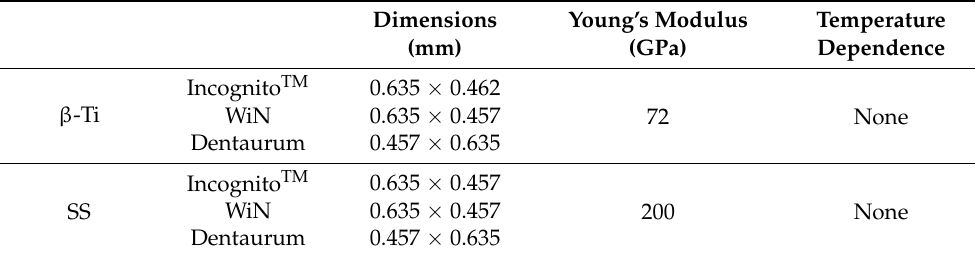
Table 1. Physical, mechanical and thermal properties of archwires. The wire dimensions in millime- ters were calculated from manufacturers’ values (0.018” × 0.025” and 0.0182” × 0.025”). Young’s moduli were calculated from Proffit